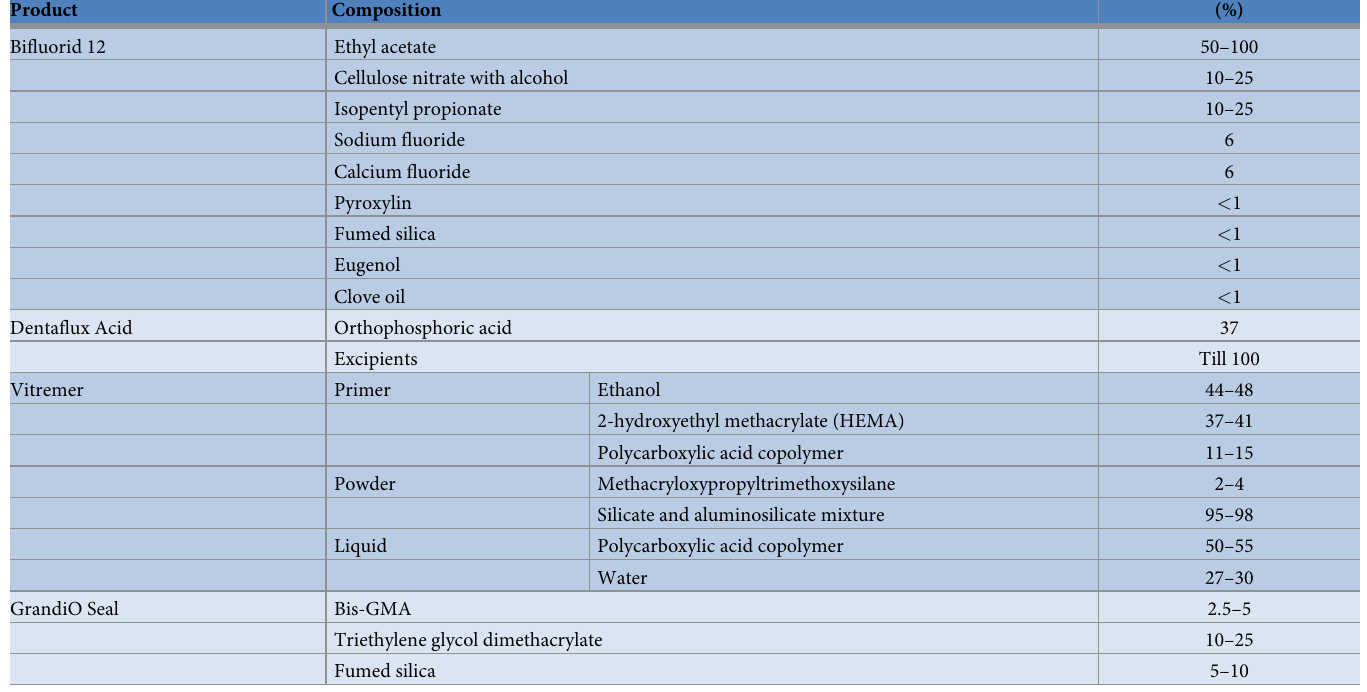
Table 1. Product composition according to material safety data sheets